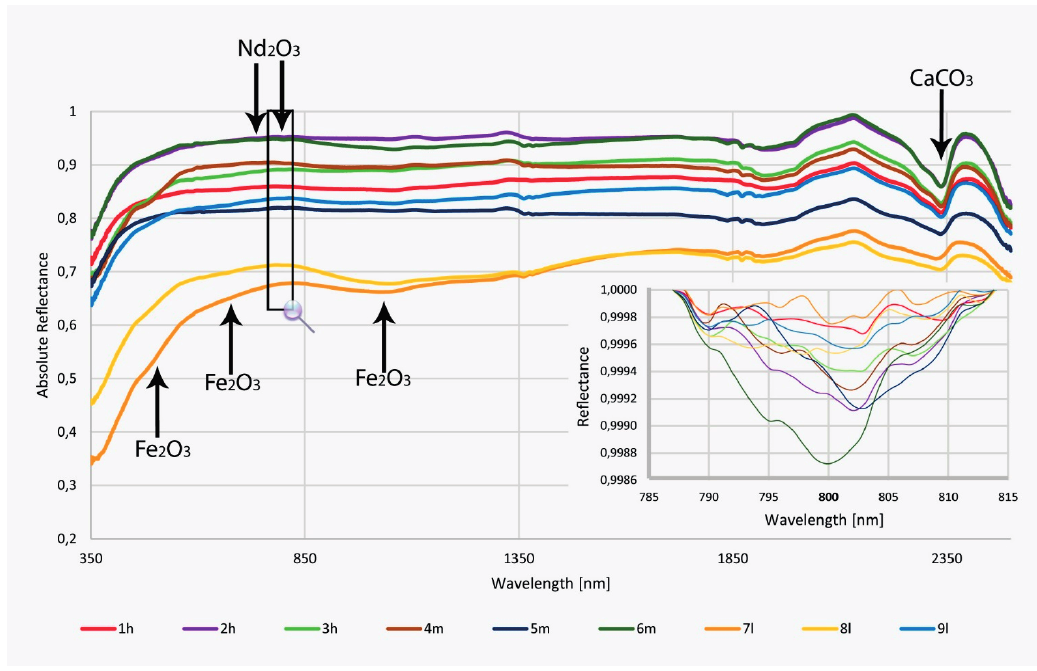
Figure 11. Resulting ASD spectra of the ground truth measurements. The zoom image shows (feature based) continuum-removed subsets of the ground truth measurements. The spectra of samples 1H, 2H, 3H, 4M, 5M, 6M and 9L show a nicely resolved calcium carbonate absorption band at 2.3 nm and a small superimposition of neodymium oxides. The spectra of samples 7L and 8L show less absorption for the calcium carbonate band. The two spectra clearly show three iron oxide absorption bands. Hence, the spectra are correlated with the chemical results in Tables 2 and 3. The 800 nm absorption band is the most diagnostic feature for neodymium detection. A correlation between the absorption depth and neodymium content is visible (especially for the spectra of samples 5M, 2H, 6M, 4M and 3H), if they contain no iron